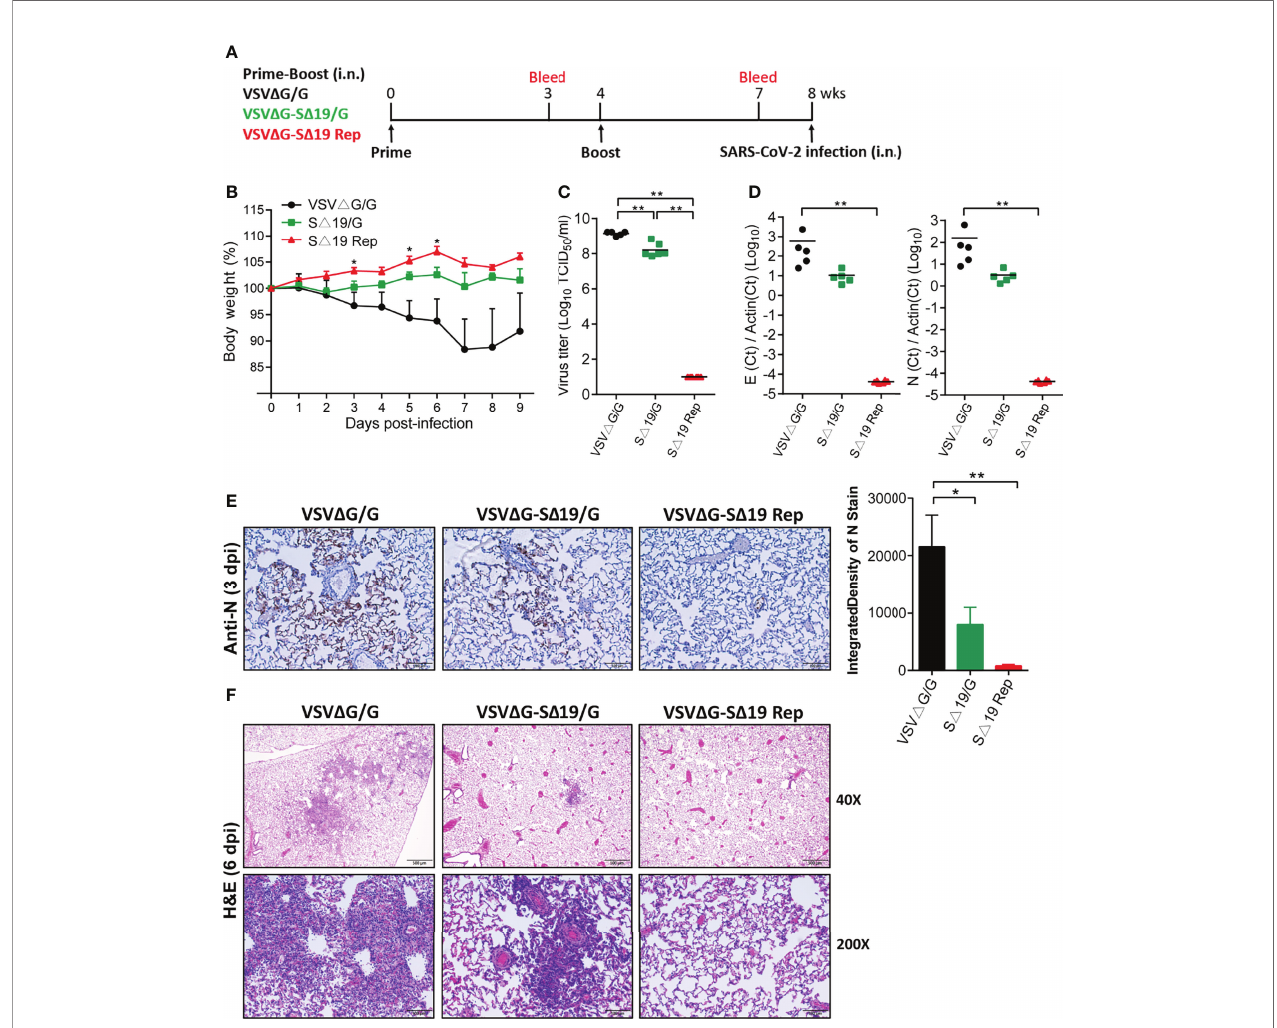
FIGURE 3 | Prime-boost S D 19 Rep vaccination protects hamsters from SARS-CoV-2 infection. (A) Experimental design of the prime-boost vaccination and SARS- CoV-2 challenge (1×10 5 TCID 50 /hamster; i.n.) in hamsters. (B) Body weight loss post-SARS-CoV-2 challenge. (C) The virus titers of SARS-CoV-2 in the lung at 3 dpi were detected by TCID 50 assay. (D) Viral RNA transcripts of E and N genes in the lung (3 dpi) were measured by quantitative real-time PCR. (E) Viral N protein expression in the lung (3 dpi) was detected by immunohistochemistry and quanti fi ed using ImageJ software. Scale bar: 100 m m. (F) H&E staining of lung tissue at 6 dpi. Scale bar: 500 m m (40X) and 100 m m (200X). *P < 0.05; **P <